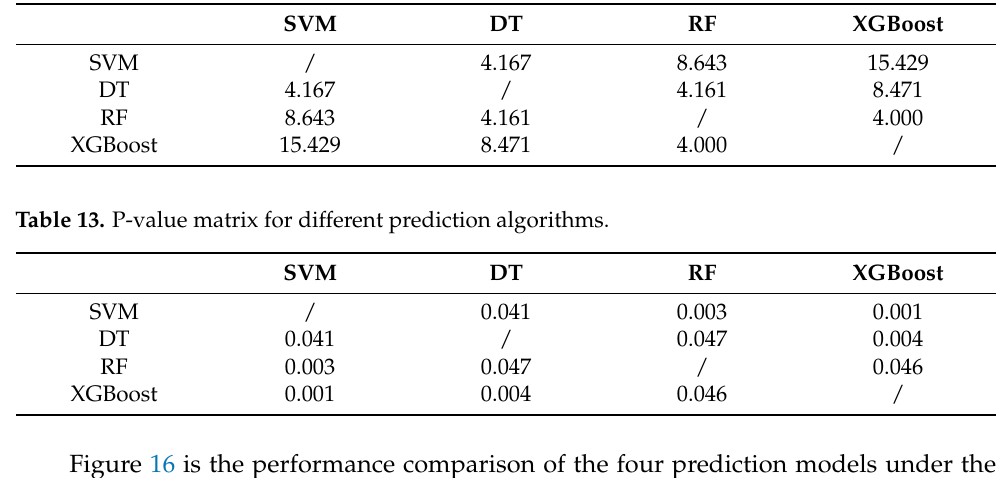
Table 12. McNemar statistic matrix for different prediction algorithms.